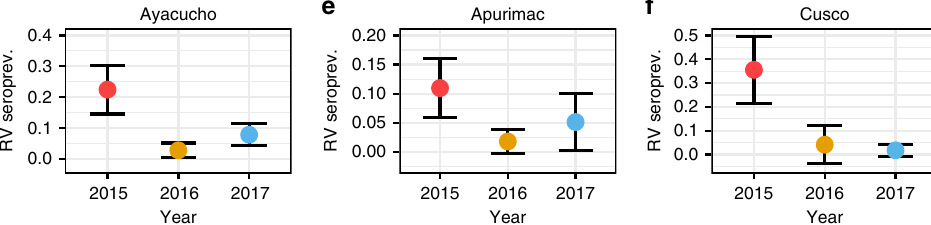
Fig. 2 Seroprevalence of VBRV in D. rotundus and geographic distribution of outbreaks in cattle. a – f The seroprevalence of VBRV in D. rotundus , grouped by year and department within Peru, are shown in the surrounding plots ( a – f ), with the location of each department marked by the corresponding letter on the map. Seroprevalence within a department is displayed as the mean average with 95% con fi dence intervals based upon sample size. Sample sizes for A-F in ascending year order are as follows: A-5, 21; B-144, 126; C-158, 72, 116; D-107, 181, 218; E-146, 167, 78; F-45, 24, 111. g Locations of laboratory con fi rmed rabies mortality in livestock between 2015 and 2017 are shown coloured by year (2015 = red, 2016 = yellow, 2017 = blue) on the map of Peru. The location from which the PCR positive bat saliva sample originated is shown by the black diamond. Source data are provided as a Source Data fi